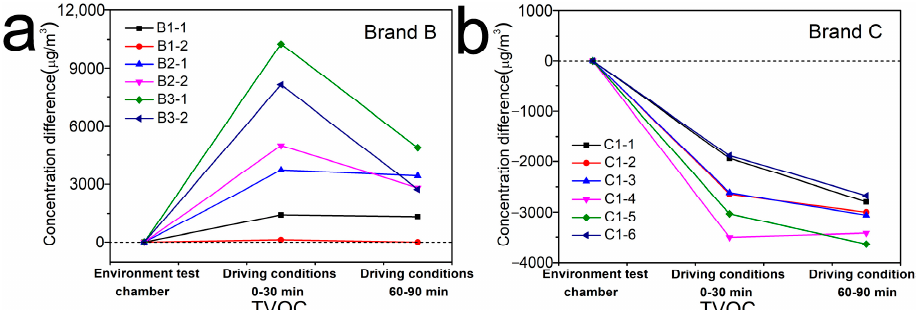
Figure 5. Concentration changes of eight confirmed compounds inside six vehicles of Brand C under different conditions (( a ). Vehicle C1-1; ( b ). Vehicle C1-2; ( c ). Vehicle C1-3; ( d ). Vehicle C1-4; ( e ). Vehicle C1-5; ( f ). Vehicle C1-6)). Y -axis indicates the concentration difference between C D(0–30min) and C E , C D(60–90min) and C E .